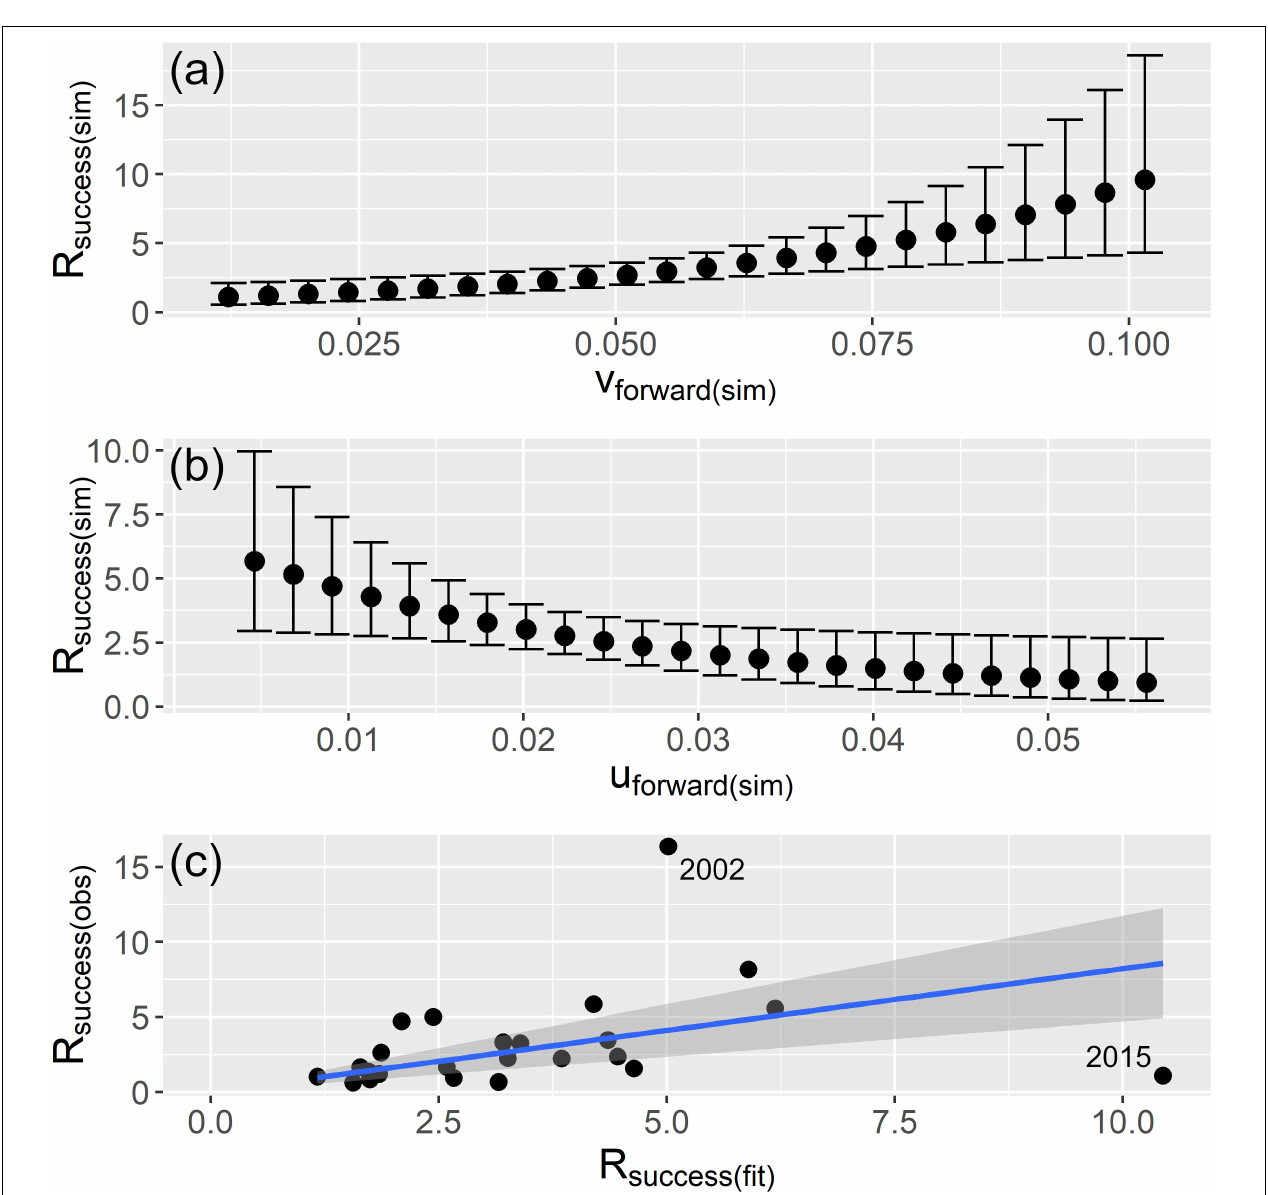
FIGURE 5 | Simulated (sim) relationships from the best model (full model forward ) where R success (R age 2 /SSB t − 2 ) is estimated with 95% credible intervals for equally simulated values of the range of v forward in panel (a) and u forward in panel (b) ; and (c) relationship of observed (obs) versus fitted (fit) R success